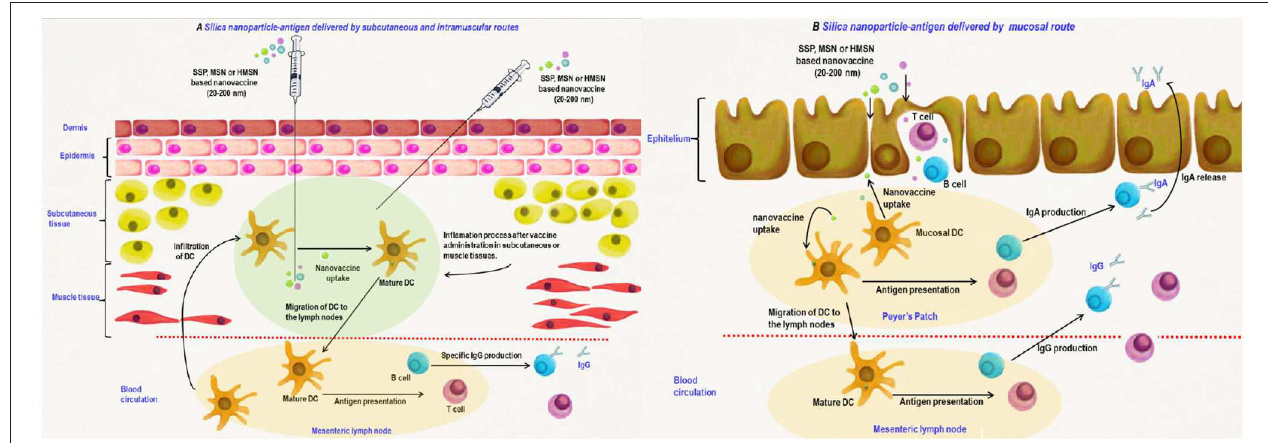
FIGURE 7 | Silica nanomaterials-based vaccines delivery by parenteral (A) and mucosal (B) routes. Adapted with permission Navarro-Tovar et al. (2016) Copyright 2016, Taylor & Francis.